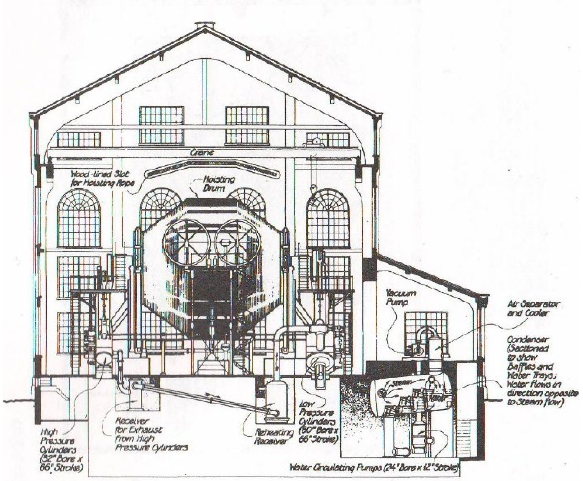
Figure 10. Cross section of the Quincy Mine Hoist Engine house, 1921 (Quincy Mining Company HAER,